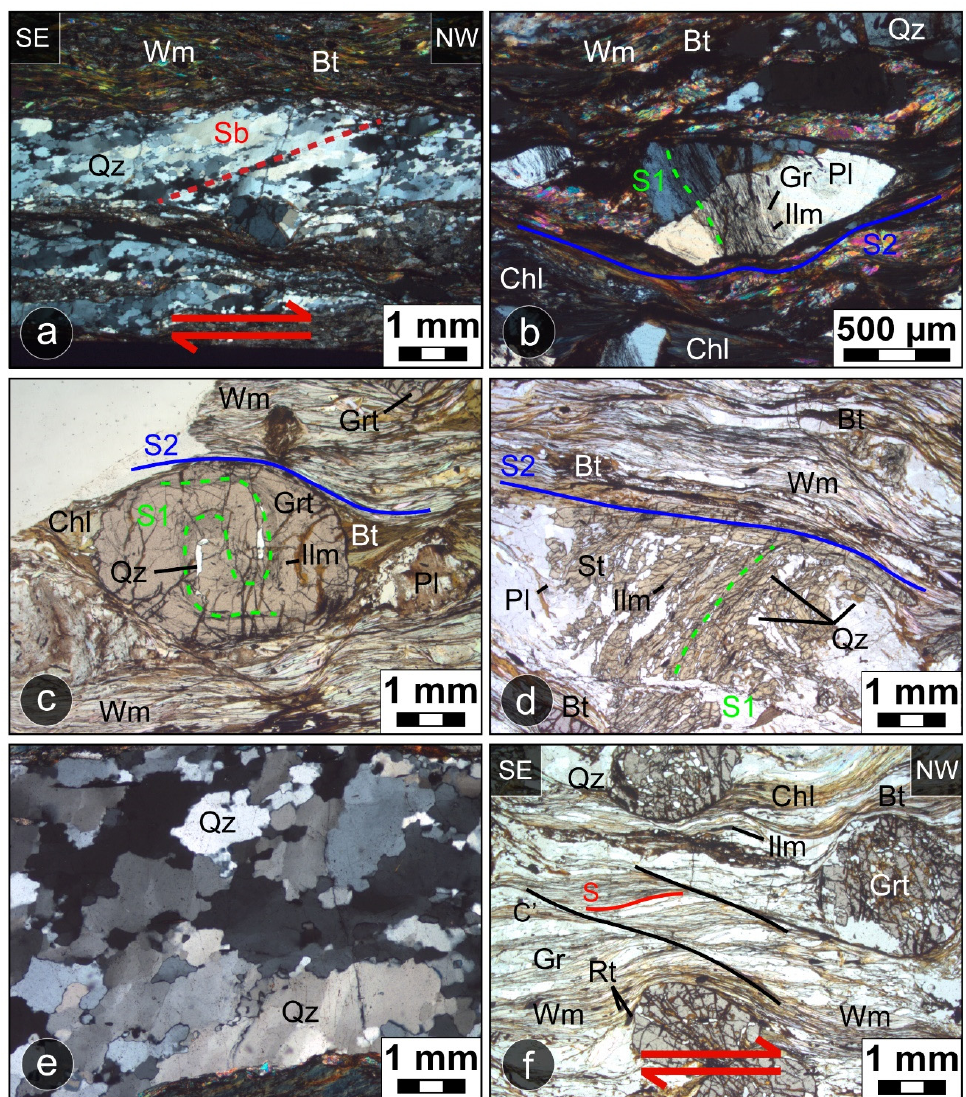
Figure 5. ( a ) Dynamically recrystallized quartz in staurolite-bearing micaschist showing lobed and irregular boundaries indicative of grain boundary migration (GBM). Subgrain rotation recrystallization (SRR) overprinting is highlighted by the presence of “core and mantle” structure. An oblique foliation, Sb, defined by elongated quartz, is present (XPL); ( b ) oligoclase porphyroclast, in oligoclase-bearing micaschist, showing an internal foliation S 1 (green line), defined by ilmenite + graphite. Oligoclase is wrapped by the main foliation S 2 (blue line) defined by quartz + white mica + biotite (XPL); ( c ) garnet porphyroclast, in garnet-bearing mylonitic micaschist, showing an internal foliation S 1 (green line) defined by ilmenite + elongated quartz. Garnet is wrapped by the main foliation S 2 (blue line) defined by white mica + biotite (PPL); ( d ) staurolite in staurolite-bearing micaschist, showing an internal foliation S 1 (green line), discordant with respect to the foliation in the rim which is in continuity with the external foliation S 2 (blue line). This observation point to an inter- to early-syn tectonic growth of staurolite (PPL); ( e ) dynamically recrystallized quartz in staurolite-bearing micaschist showing lobate and irregular grain boundaries indicative of GBM (XPL); ( f ) C’–S fabric (S plane = red dashed line, C’ plane = black line) in garnet-bearing micaschist, indicating a top-to-the NW sense of shear